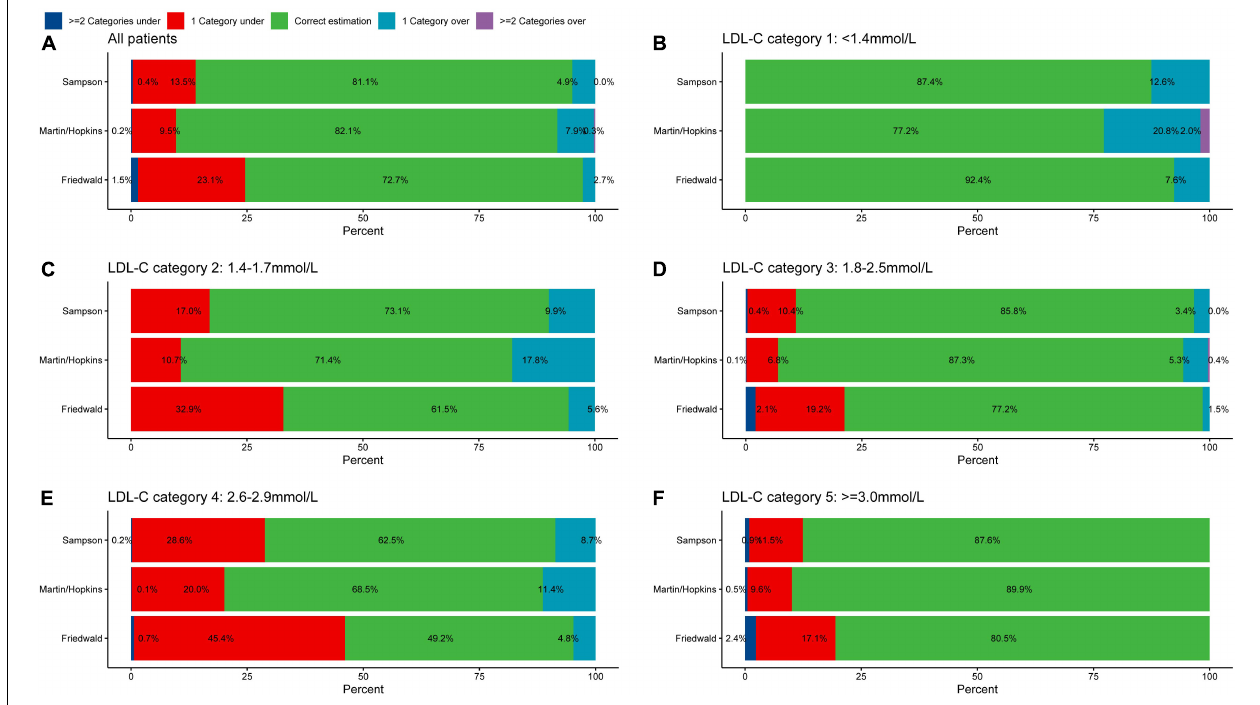
FIGURE 2 | Proportion of misclassified patients per direction by estimated LDL-C category. Graphs represent the total percentage of under classified and overclassified patients within each LDL-C category. Values to the left and right of 0 on the x -axis indicate percentage under classified and percentage overclassified, respectively. Proportion of misclassification in (A) all patients, (B) LDL-C category 1: < 1.4 mmol/L, (C) LDL-C category 2: 1.4–1.7 mmol/L, (D) LDL-C category 3: 1.8–2.5 mmol/L, (E) LDL-C category 4: 2.6–2.9 mmol/L, and (F) LDL-C category 5: ≥ 3.0 mmol/L. LDL-C, low-density lipoprotein